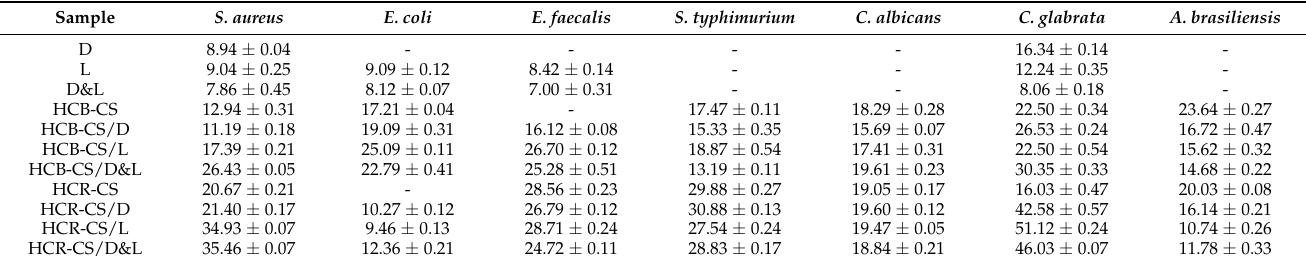
Table 4. Inhibition zone (mm) of prepared electrospun samples in contact with different microorganism tests.